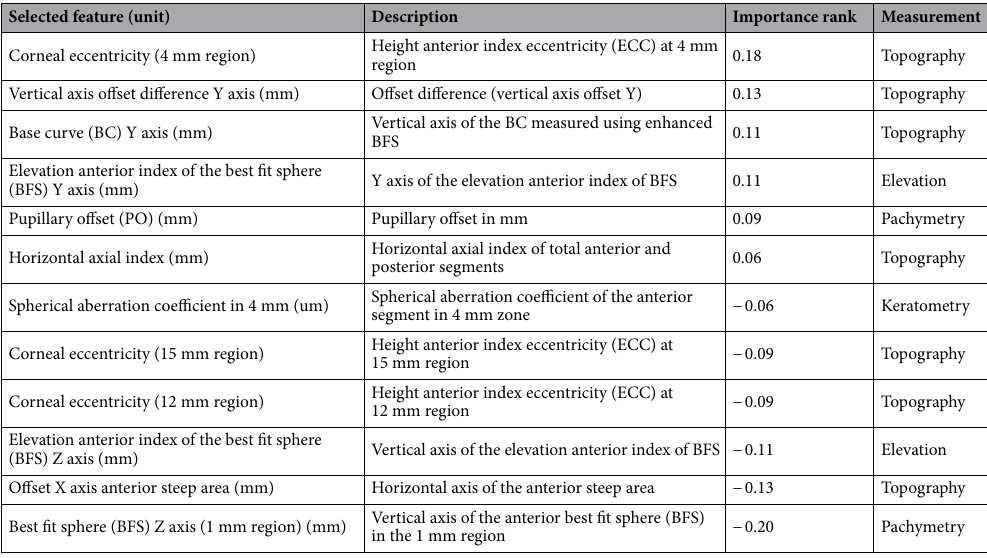
Table 4. Selected features from optical coherence tomography (OCT) imaging of cornea.